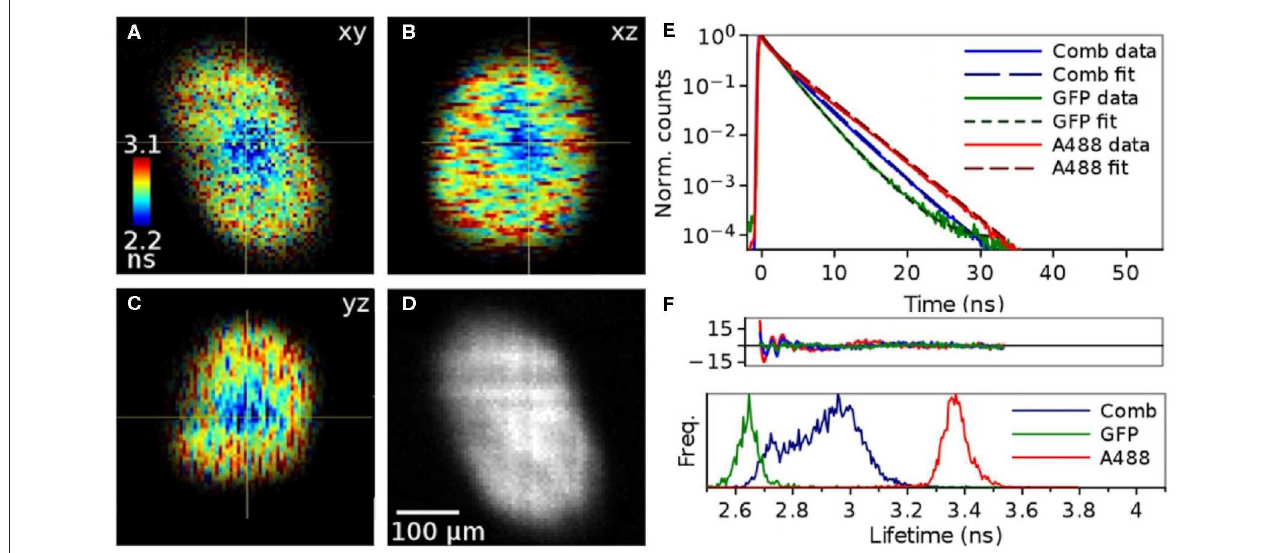
FIGURE 14 | TCSPC-based lightsheet FLIM images of cancer cell spheroids with two different fluorescent labels, one throughout the spheroid and one on the surface only. (A) xy FLIM image, with the color-encoded fluorescence lifetime contrast given by the color scale bar on the left, (B) xz FLIM image, (C) yz FLIM image, and (D) xy fluorescence intensity image, with a 100 µ m scale bar to indicate spatial dimensions. (E) Representative fluorescence decays of samples with one or both fluorescent labels on a semi-logarithmic plot. (F) Fluorescence lifetime histograms of samples with one or both fluorescent labels. Reproduced from Hirvonen et al. [